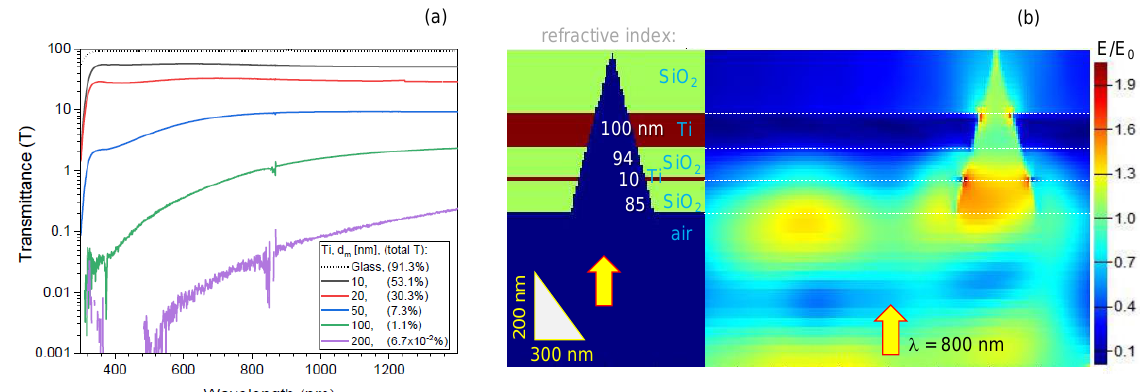
Figure A2. Simulations of the d 1 (y-axis) and d 3 SiO layers. Layer-3 (SiO ) is varied in steps of 20 nm: d 3 = 73.7 nm ( a ), d 3 = 93.7 nm ( b ) and d 3 = 113.7 nm ( c ); 2 structure is shown in Figure 2a; thickness d 2 = 7.9 nm. Normal incidence θ = 0 ◦ .